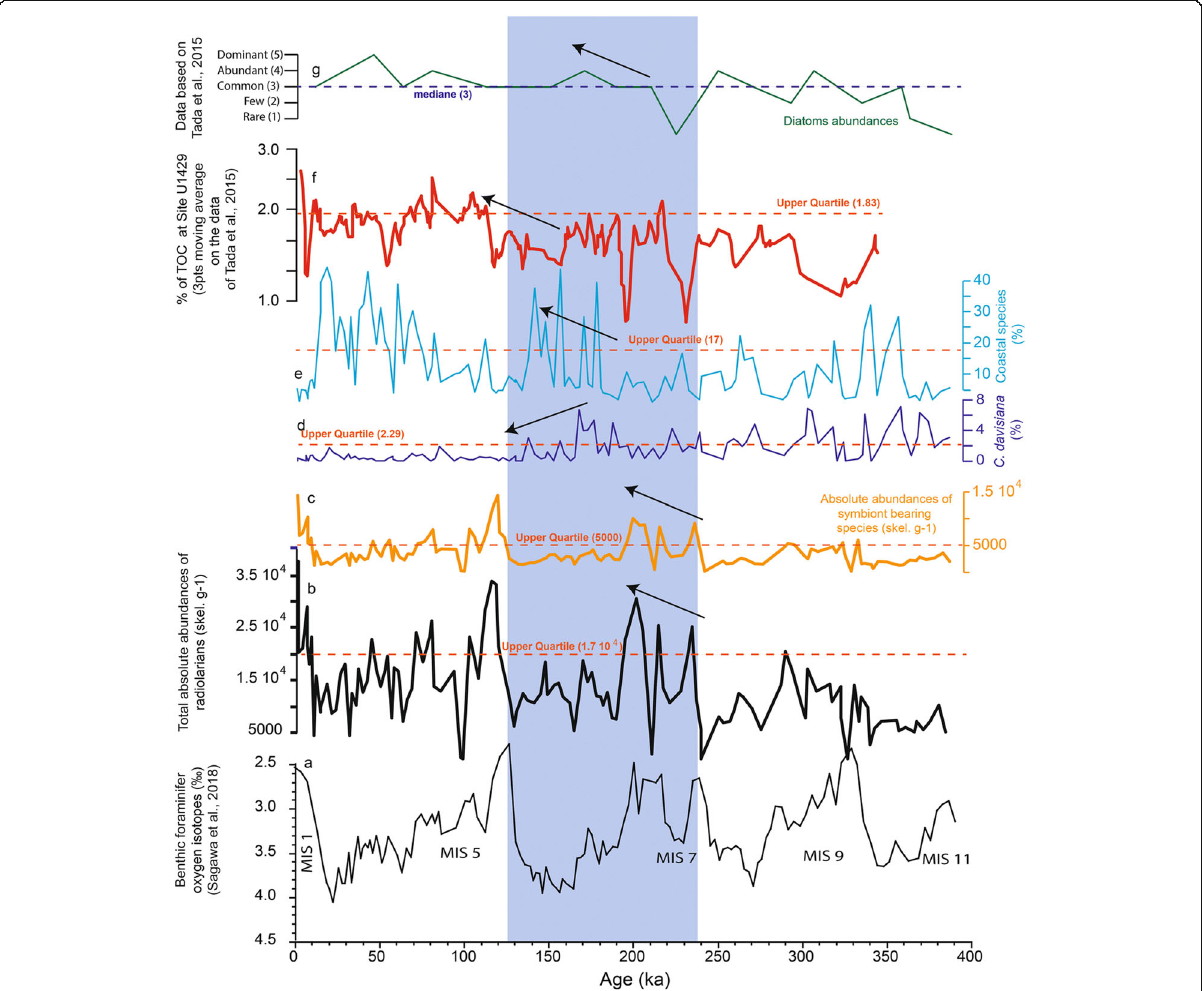
Fig. 9 Temporal fluctuation of the local primary productivity: a benthic foraminifera isotope curve of Sagawa et al. (2018), b radiolarian absolute abundance, c radiolarian absolute abundance of species bearing algal symbiosis based on Zhang et al. 2018 ( A . vinculata , B . scutum , L . hispida , P . obeliscus , P . praetextum , P . clausus , A . lappacea / spinosa , D . tetrathalamus , D . muelleri , P . pylonium group, S . resurgens , S . streptacantha , Tetrapyle circularis / fruticosa group, L . reticulata , Heliodiscus spp., D. elegans ), d C . davisiana (%), e continental shelf species (%), f total organic carbon (TOC) (%), and g diatom